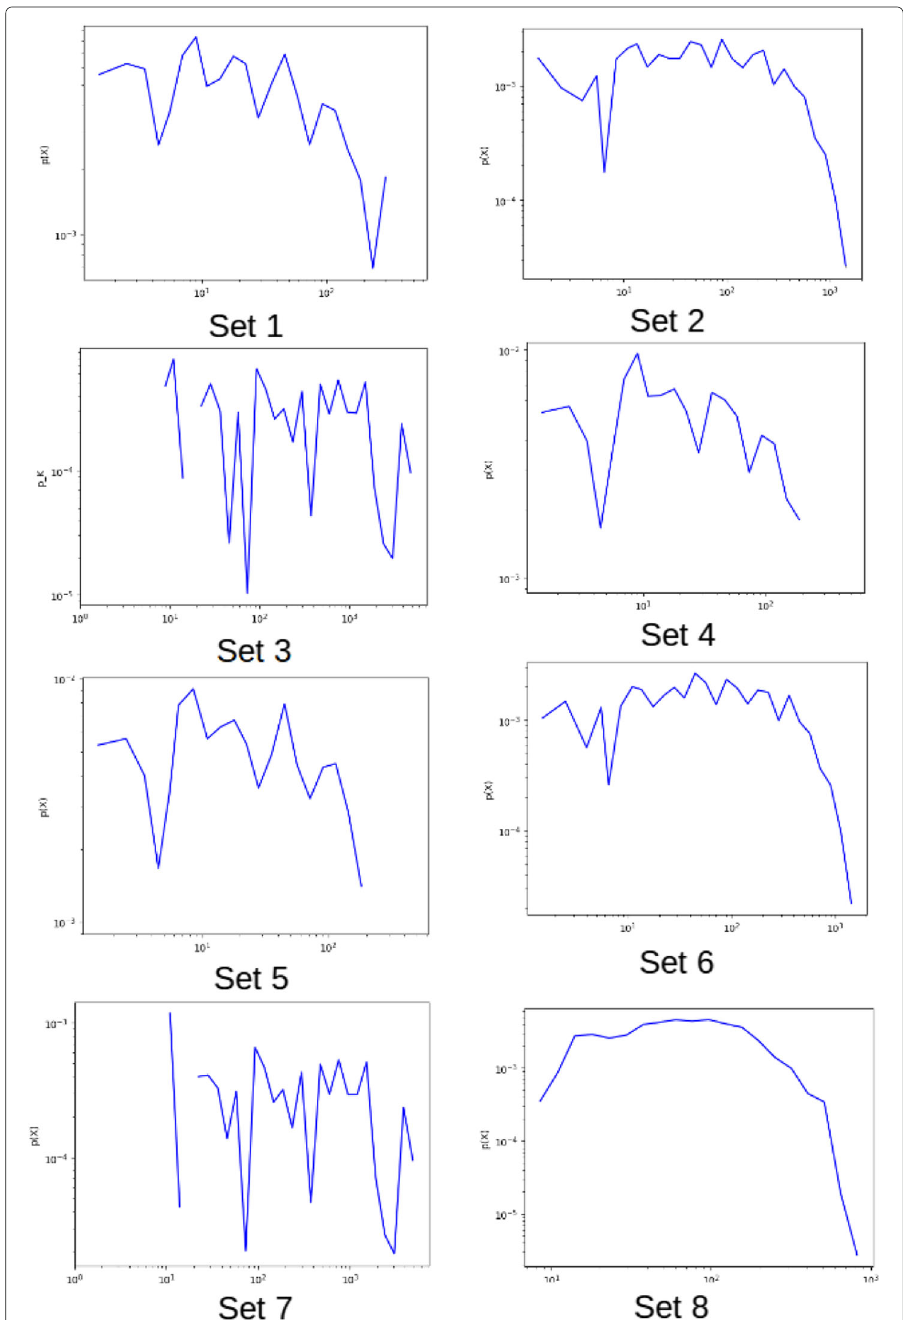
Fig. 4 Degree distributions of the City extraction network for the eight datasets described in Table 3, in support of the findings in ResearchQuestion2 . The X-axis and Y-axis respectively plot the degree and its empirical frequency in the network. Scales are log-log